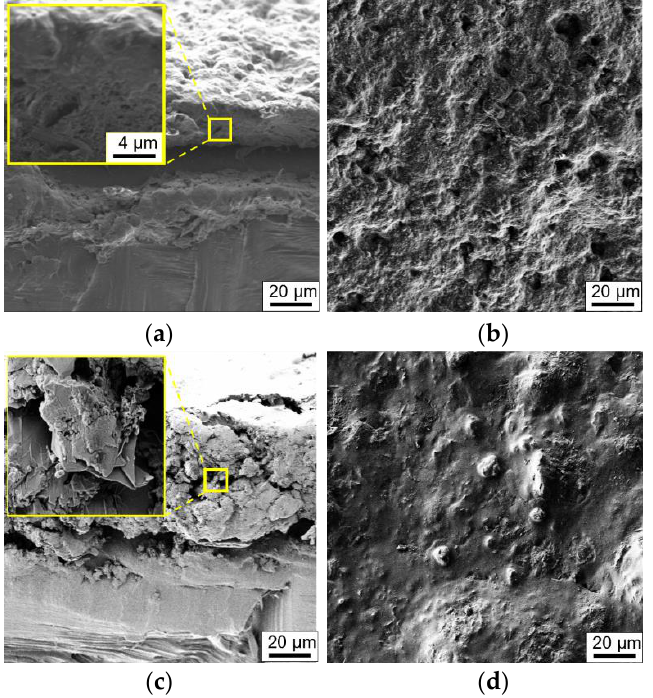
Figure 9. SEM images of ( a ) the cross-section and ( b ) the surface of a neat PU film, and ( c ) the cross-section and ( d ) the surface of a PU film with 3.5 wt% of GNPs.